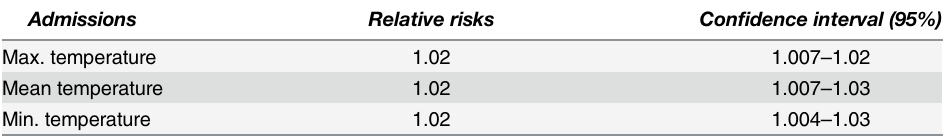
Table 2. The relationship between temperatures and daily hospital admissions for mental disorders during five years (2008 –